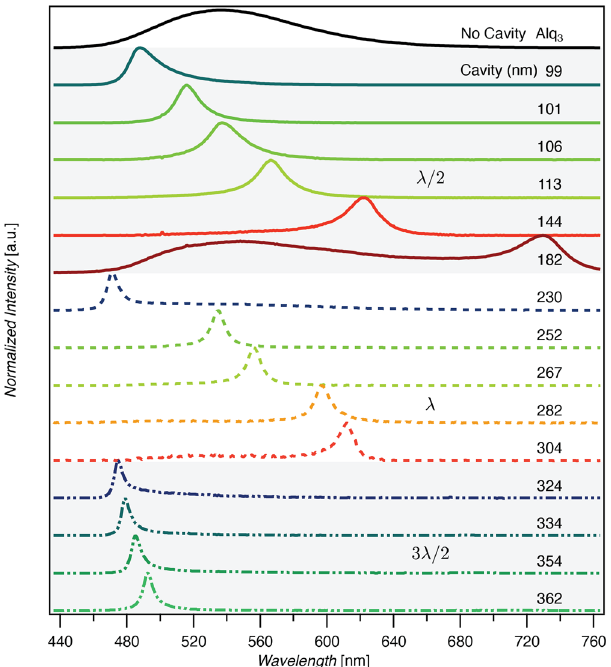
Figure 2. Electroluminescence spectra in the forward (normal) direction for an Alq 3 ITO-based OLED and for microcavity OLEDs with cavity thicknesses spanning 99–362 nm. The peak intensity for each spectrum is